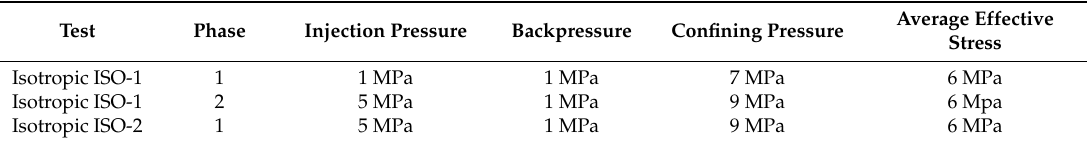
Table 3. Injection, backpressure and confining pressures for the two isotropic experiments during the hydration and testing